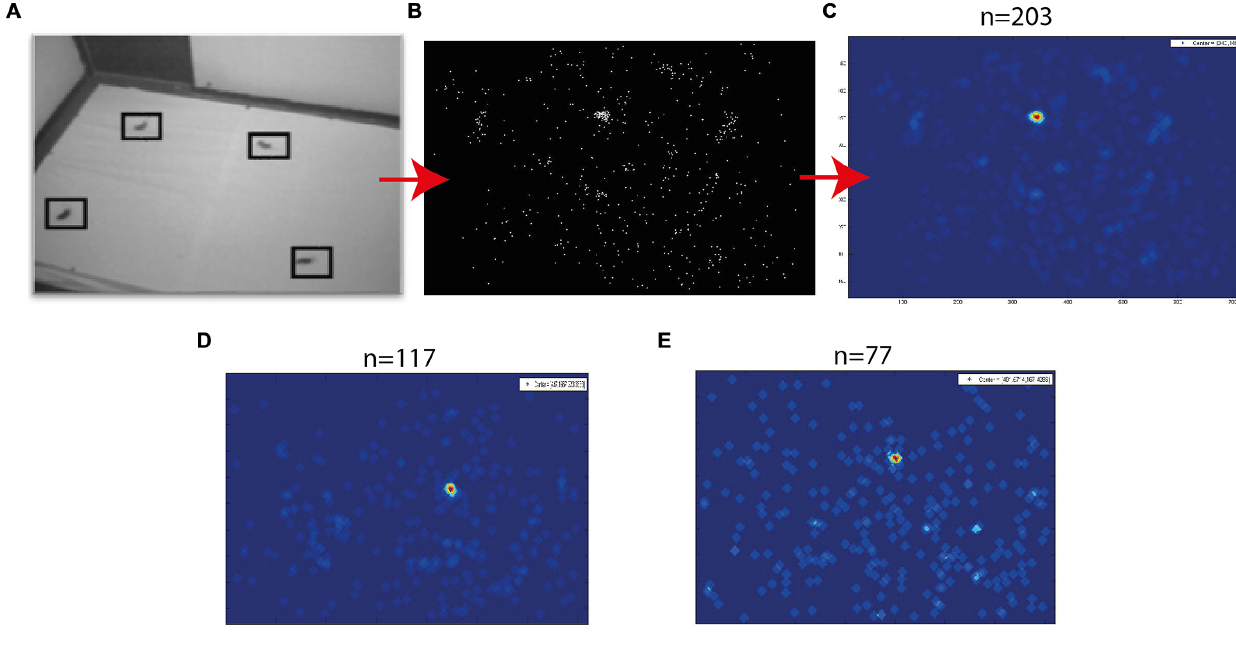
density and blue low density. (D,E) Two additional examples of density functions obtained in different experimental days. The numbers above panels (C–E) designate the number of fixation frames analyzed to obtain this